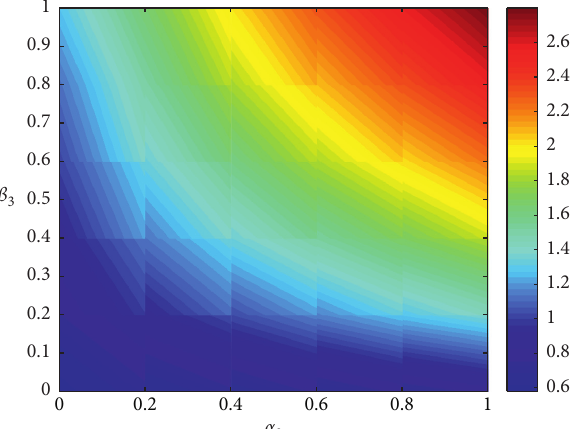
Figure 4: Effects of β R